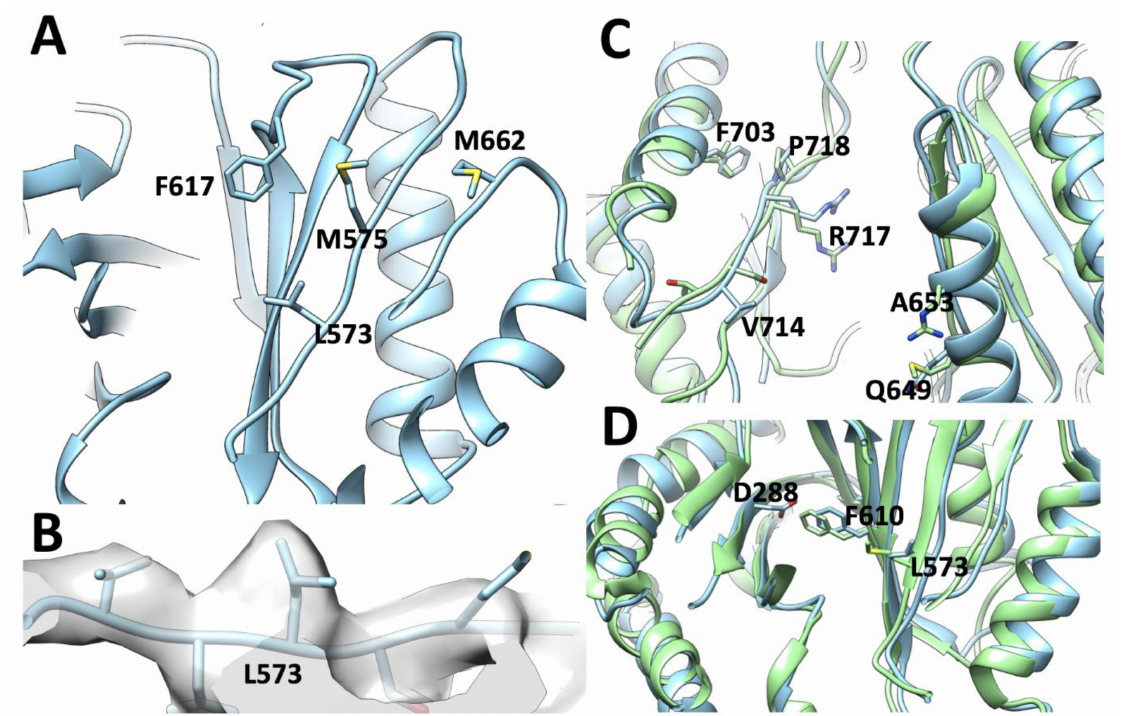
Figure 5. Close look of the drug-binding pockets of S TmAcrB G288D. ( A ) The PBP (access binding pocket) and the switch loop in S TmAcrB G288D with those residues that make up the larger hydrophobic “Met-cluster” shown. ( B ) Representative map density for S TmAcrB G288D showing the proximity of L573, which in Ec AcrB has a bulkier methionine allowing unambiguous placement of this sidechain. ( C ) The outer rim of the cleft between the two lobes of the porter domain which provide entry to tunnel 2. ( D ) Comparison of the structural di ff erences in the DBP in proximity of the G288D mutation. In all panels S TmAcrB is shown in cyan and Ec AcrB in